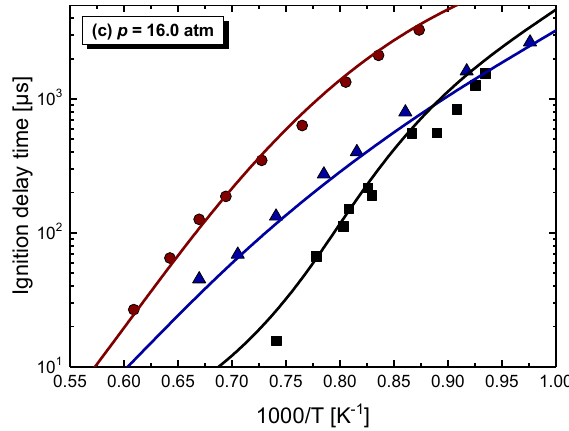
Figure 18. Reactivity comparisons of C 2 –C 4 1-alkanes at 1.2 atm ( a ), 4.0 atm ( b ) and 16.0 atm ( c ). Symbols denote experimental data measured in this study. Lines denote model simulations with NUIGMech 1.1.